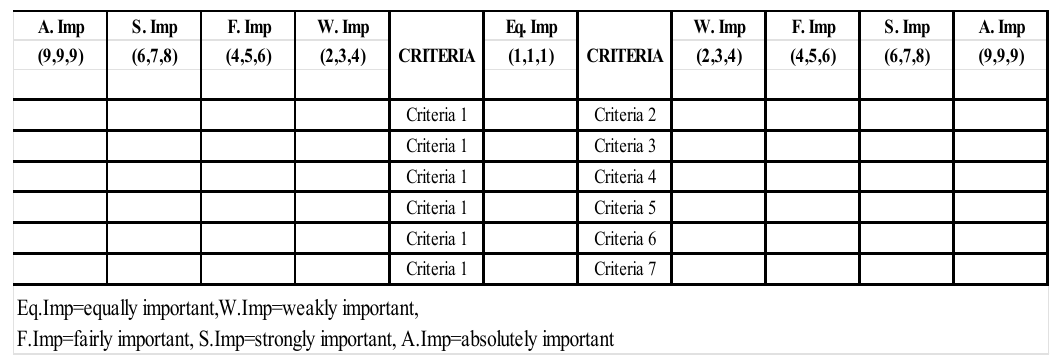
Figure 2. Example of pairwise comparison between criteria in questionnaire.